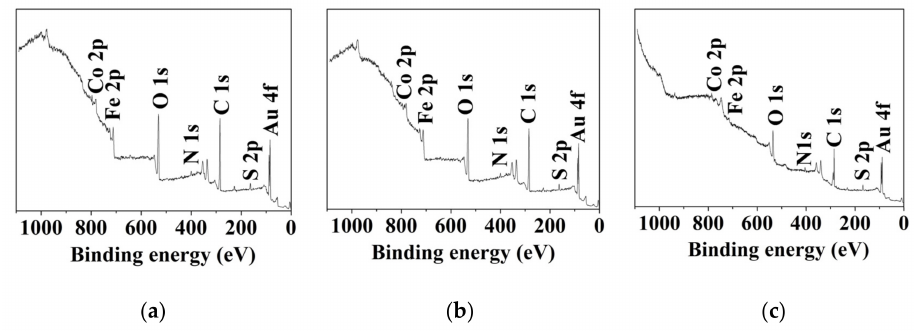
Figure 7. Wide XPS spectra of CoFe 2 O 4 /Au synthesized under the conditions in Figure 3: ( a ) 1 gold deposition cycle, ( b ) 6 gold deposition cycles and ( c ) 10 gold deposition cycles. Table 1. Surface composition of CoFe 2 O 4 /Au NPs derived from XPS. Concentration, at. % Element